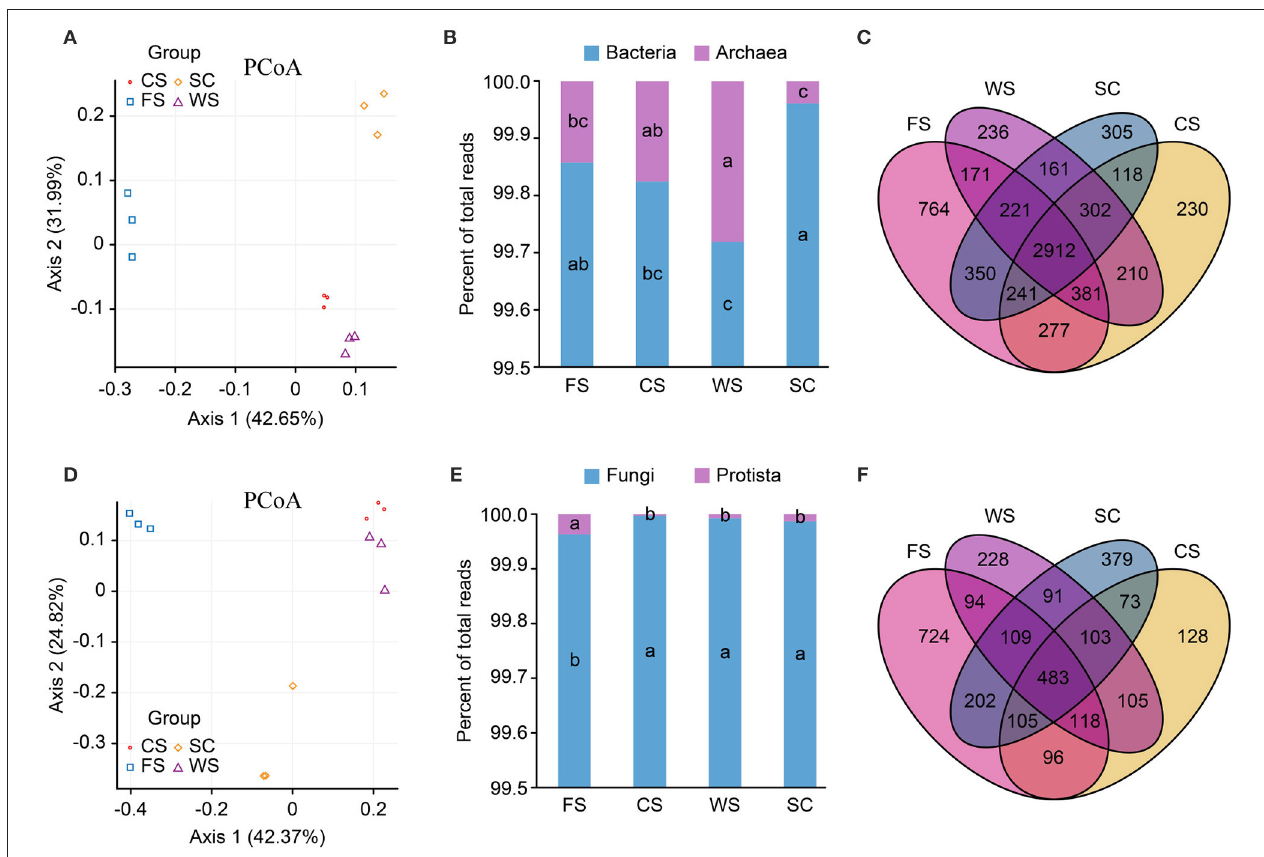
FIGURE 1 | Microbial community structure. (A–C) : bacteria. (D–F) : fungi. (A,D) : PCoA. (B,E) : histogram. (C,F) : Venn diagrams. PCoA: in the PCoA figure, a shorter distance (close) indicates that the difference between the samples in terms of the microbial community composition is small, whereas a larger difference between samples in terms of microbial community diversity is indicated by a longer distance between the samples. The more similar samples (the same sample group) will eventually converge. Histogram: relative abundance (%) of super kingdoms in the soil samples. Venn diagram: the number of species in the overlapping areas of different colors indicate the total number of species. SC, soybean continuous cropping system; FS, fallow-soybean cropping system; CS, corn-soybean rotation cropping system; and WS, wheat-soybean rotation cropping